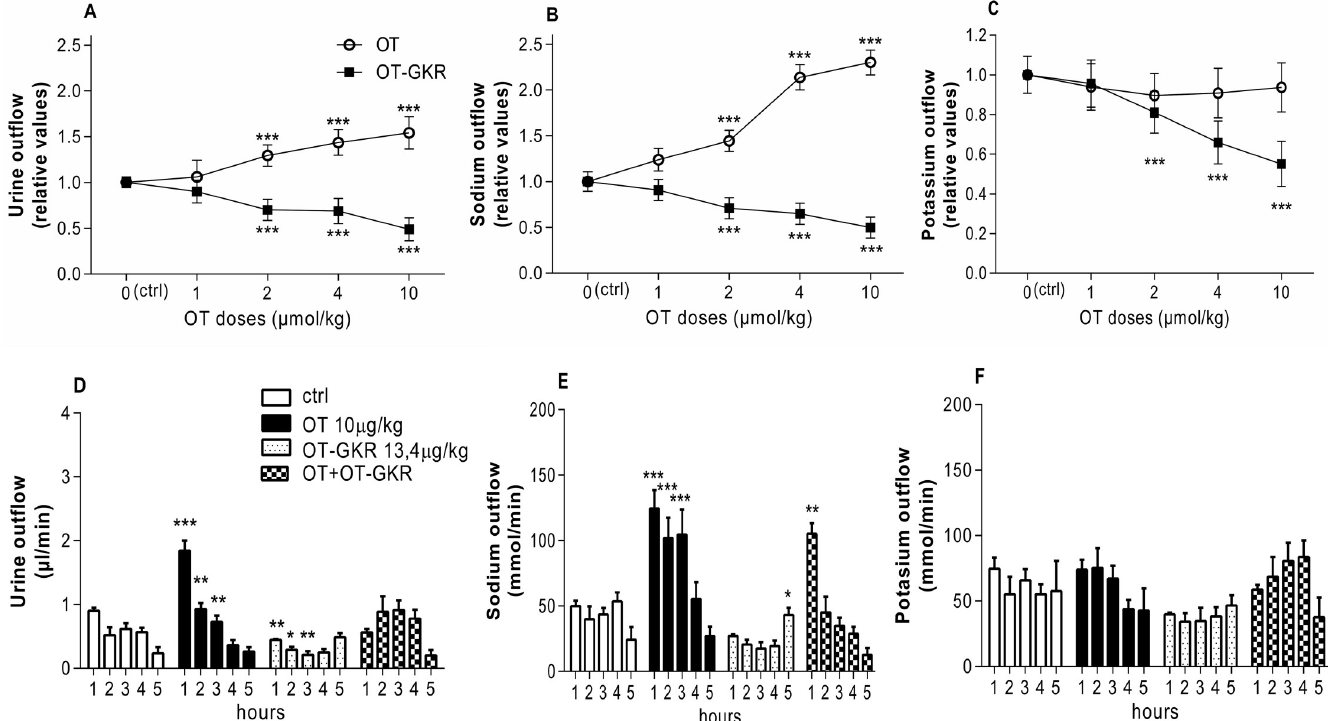
Fig 1. Dose-dependent effects of OT and OT-GKR on urine and electrolyte flow in rat kidney. (A) Equimolar doses of oxytocin (OT) and oxytocin extended form (OT-GKR) were administered intravenously at different concentrations (1, 2, 4 and 10 μ mol/kg) to assess urine, (B) sodium and (C) potassium outflow over a period of 5 hours. The effects of equimolar doses of OT and OT-GKR (10 μ mol/kg) on (D) urine, (E) sodium and (F) potassium outflow. Both OT and OT-GKR were administered as a single treatment and in combination (OT+OT-GKR). Open circles represent OT and black squares represent OT-GKR. Results are expressed as relative values compared to the control (ctrl) saline injection. Statistical analysis was performed using a one-way ANOVA followed by a Dunnett’s post-hoc test. � : p < 0.05, �� : p < 0.01, ��� : p < 0.001 compared to the ctrl injection.